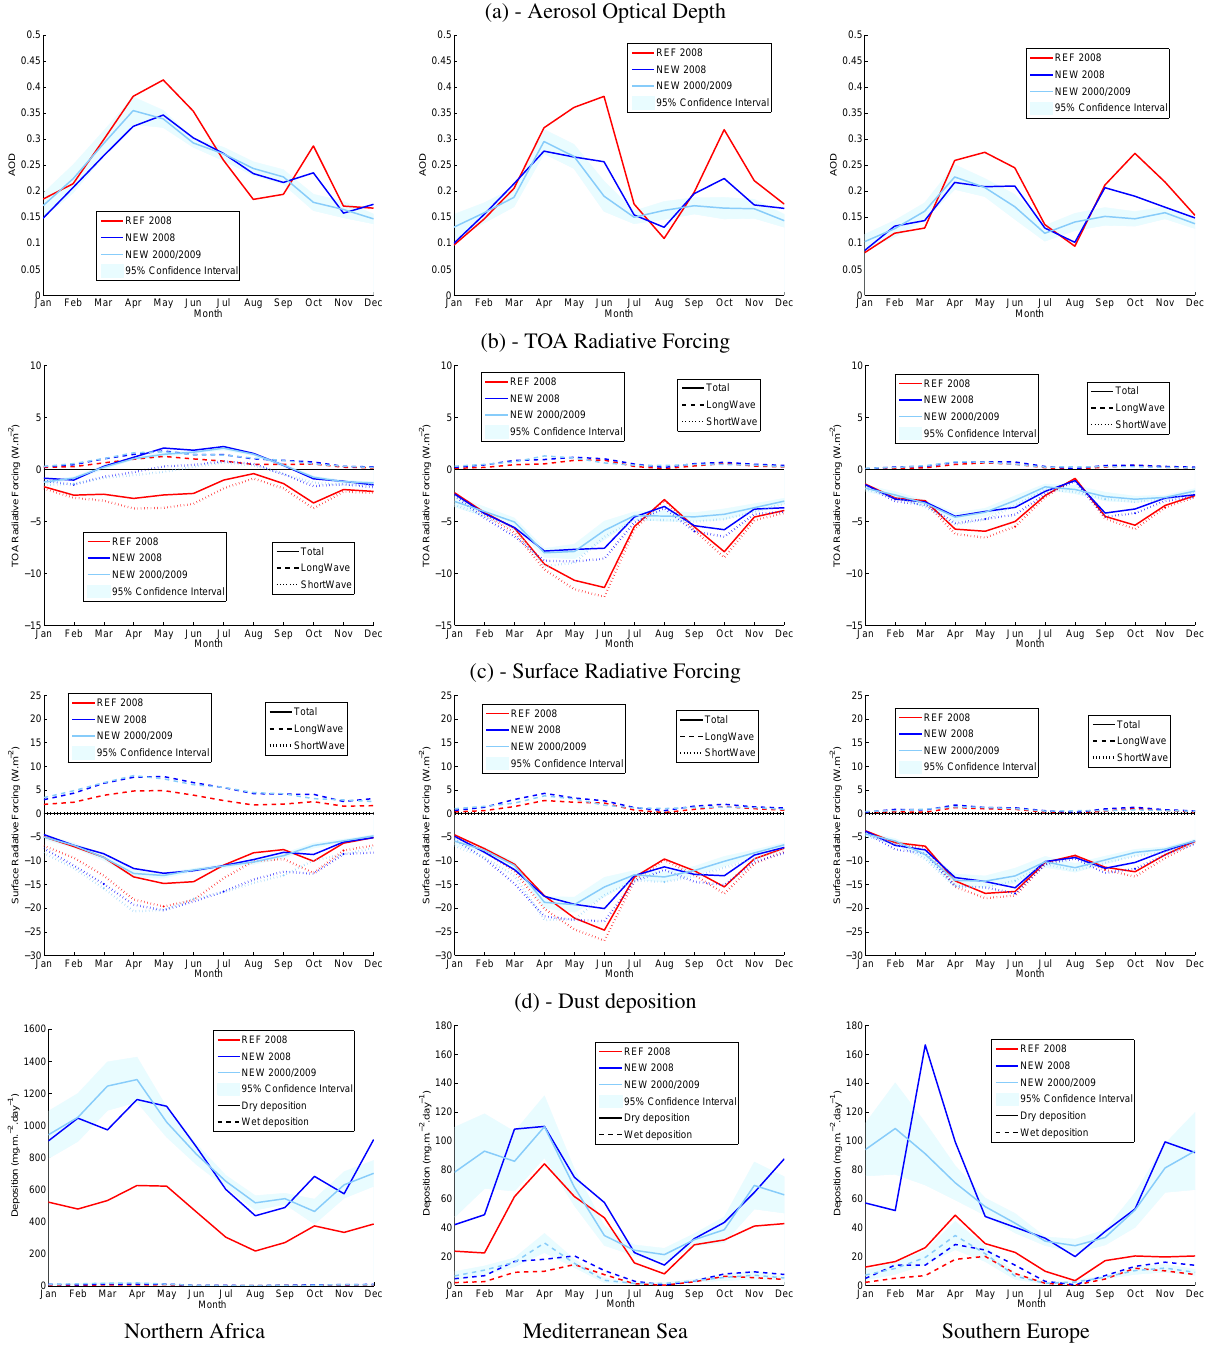
Fig. 13. Monthly means of different parameters (aerosol optical depth at 550nm, TOA and surface radiative forcing, dry and wet deposition) for three simulations: REF (red) and NEW (blue) in 2008, and NEW 2000–2009 (light blue). Means are calculated over three regions: Northern Africa (left panels), the Mediterranean Sea (middle panels) and Southern Europe (right panels).